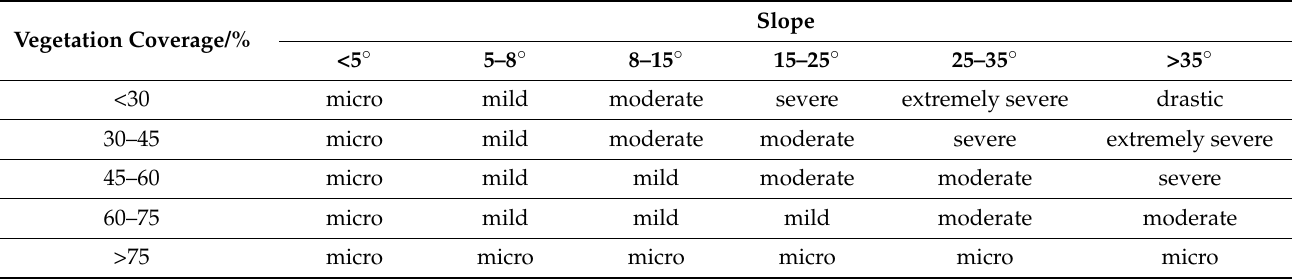
Table 4. Classification index of soil erosion.